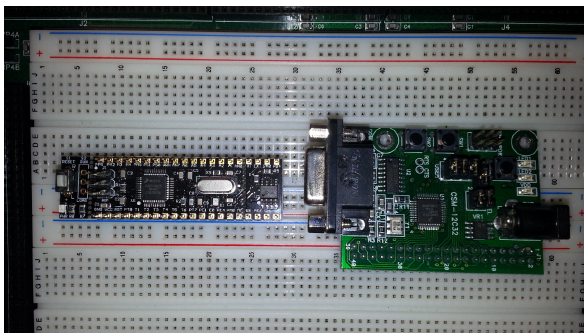
Figure 3. Dragonfly-12 Plus (right) and CSM-12C32 (left)